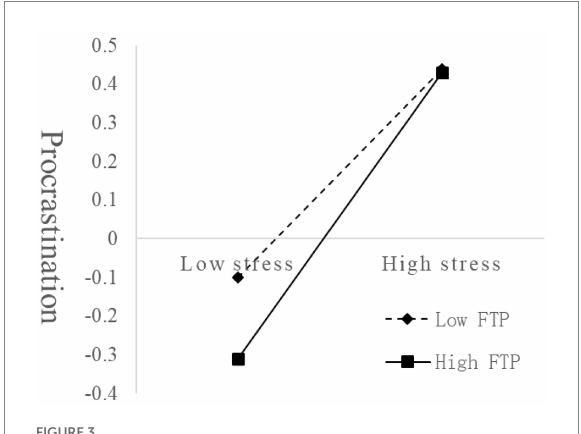
FIGURE 3 The moderating role of FTP in the relationship between stress and